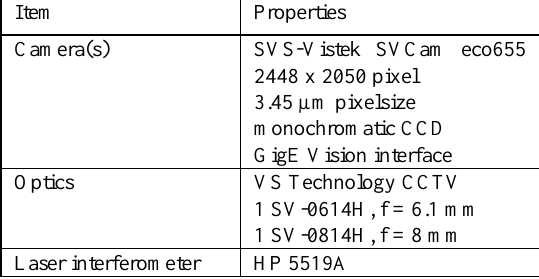
Table 4. Utilized components.